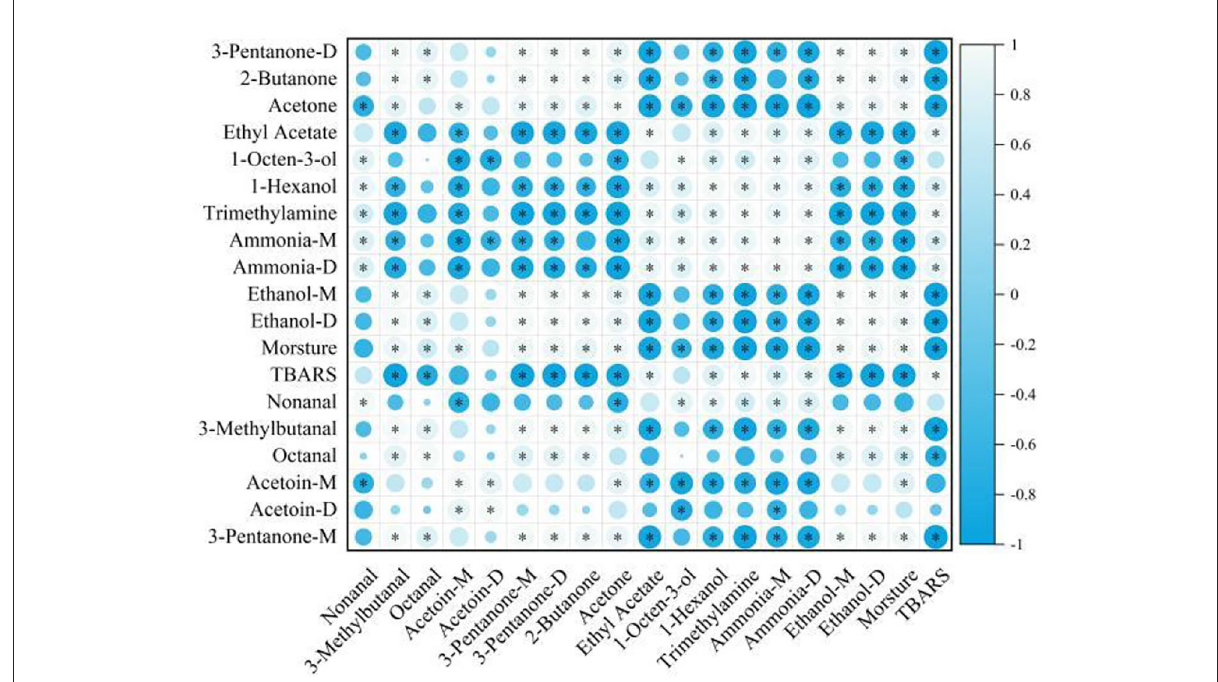
FIGURE6 Correlation analysis of flavor compounds in hairtails during the air-drying